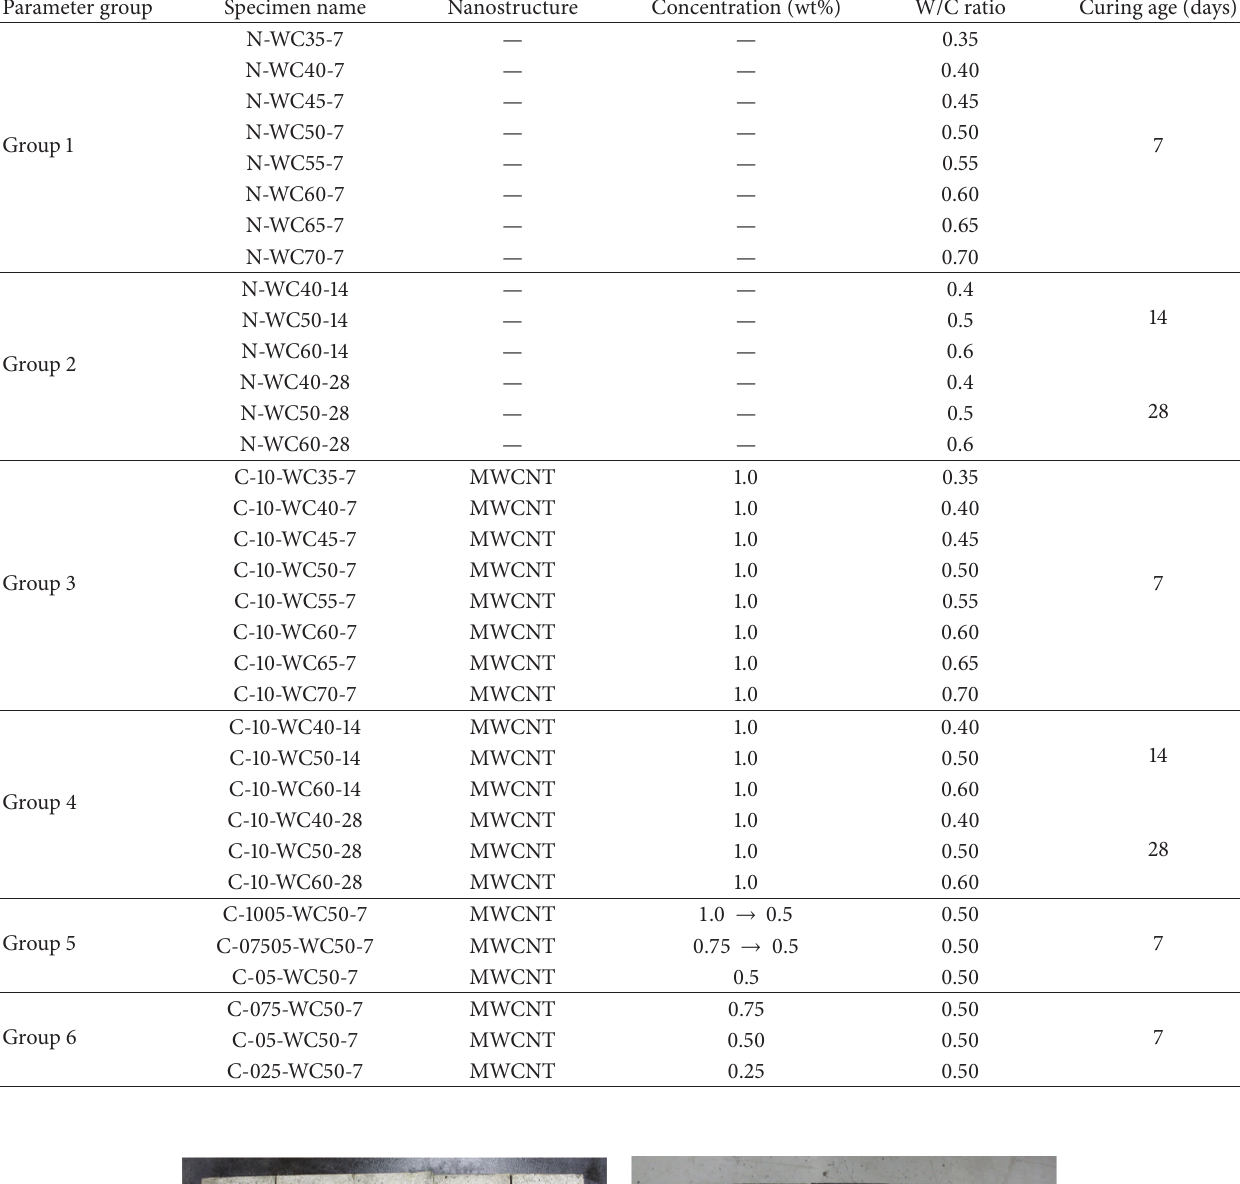
Table 1: Test parameters.